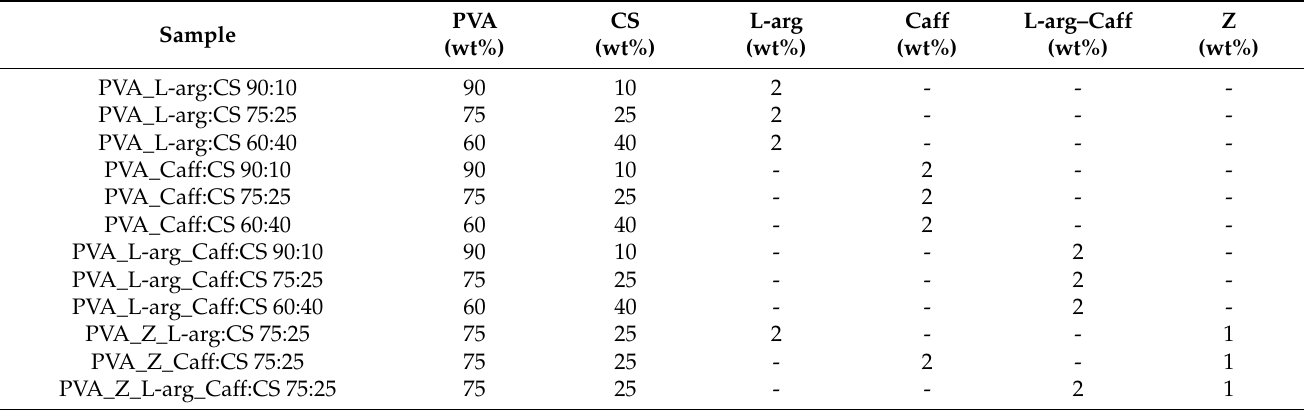
Table 4. Composition of the